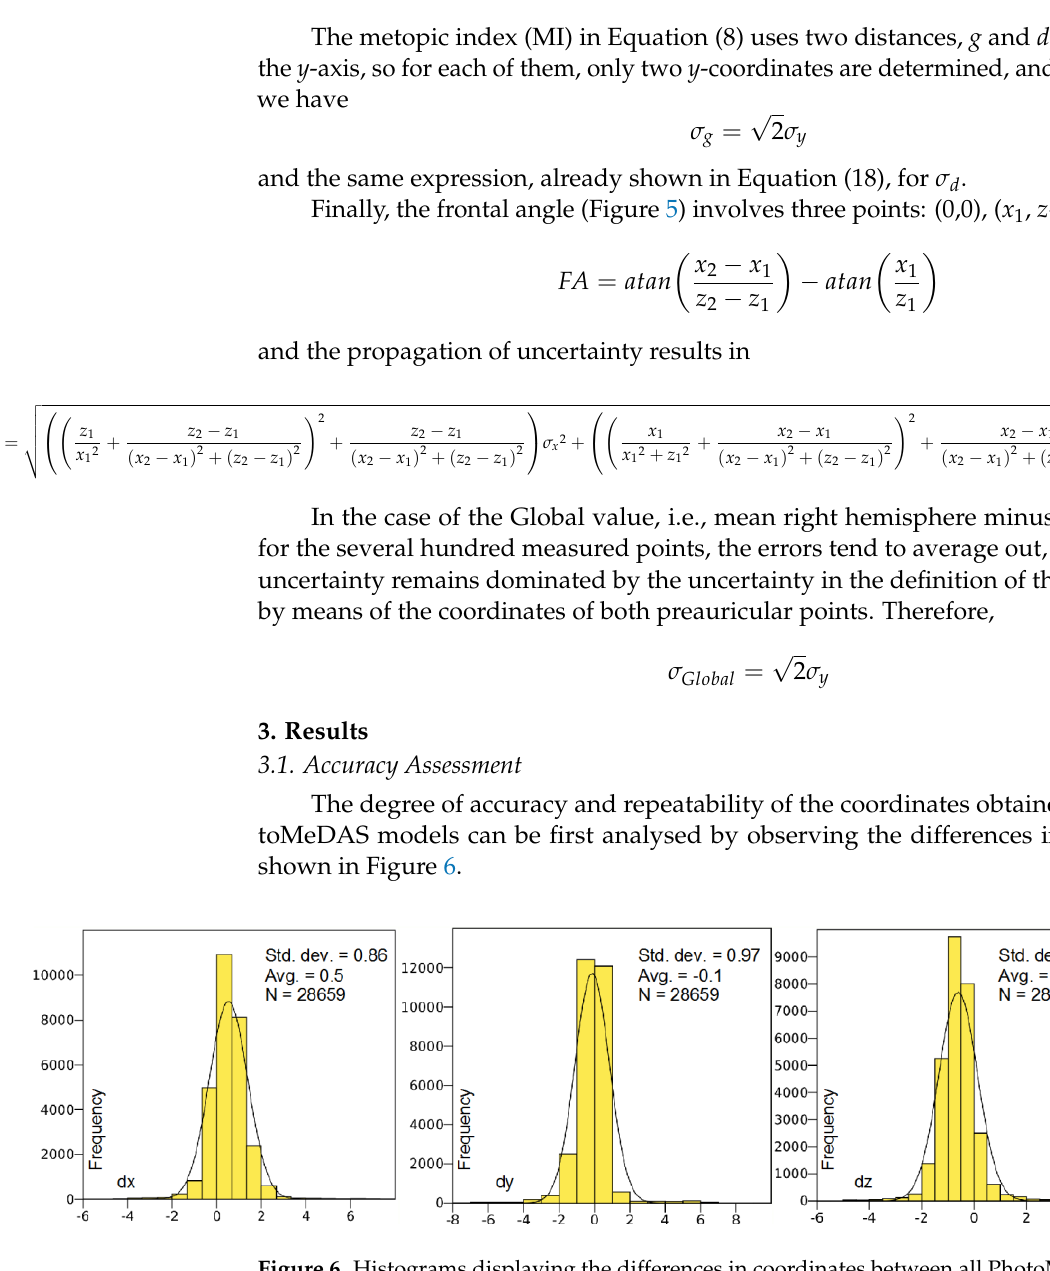
Table 2. Results of the similarity and scale transformations between PhotoMeDAS coordinates and the CNC CMM coordinates (ground truth): mean and standard deviation. The scale factor in brack- ets equals 1 + differential scale.